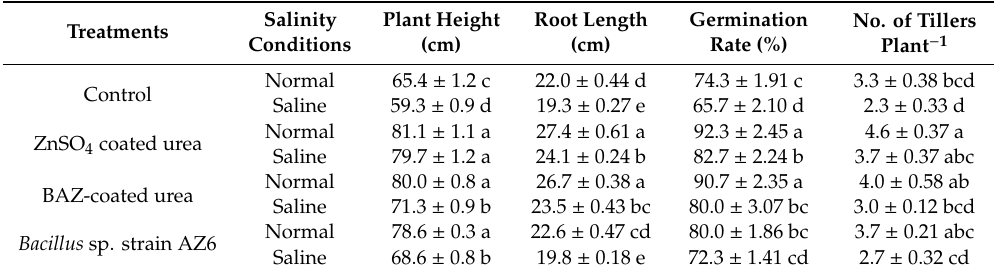
Table 1. The impact of BAZ ( Bacillus augmented ZnO)-coated urea on growth parameters of wheat under salinity stress.